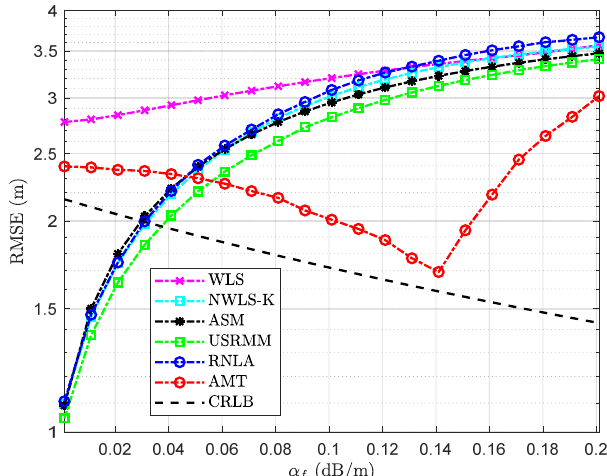
= 4 dB, and the side length of the i